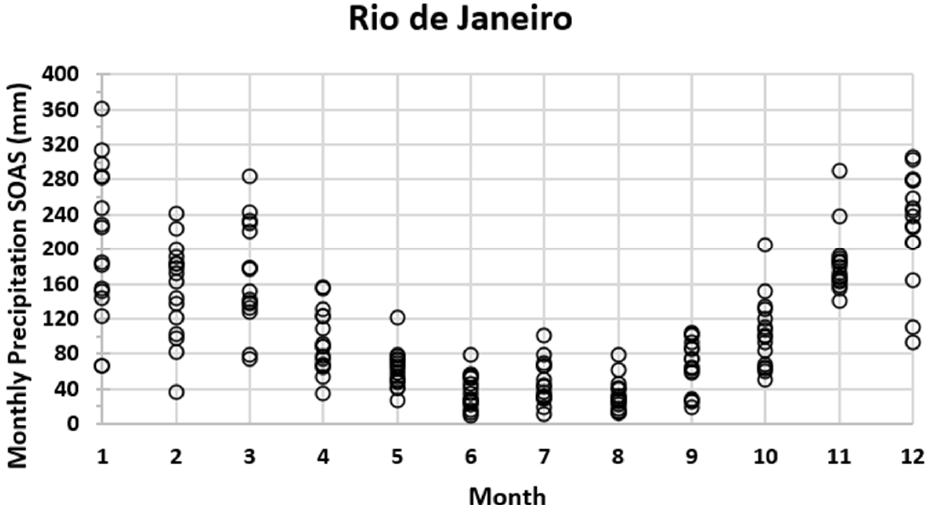
Figure 4. SOAS monthly areal precipitation averages between 2000 and 2015 for Rio de Janeiro State.